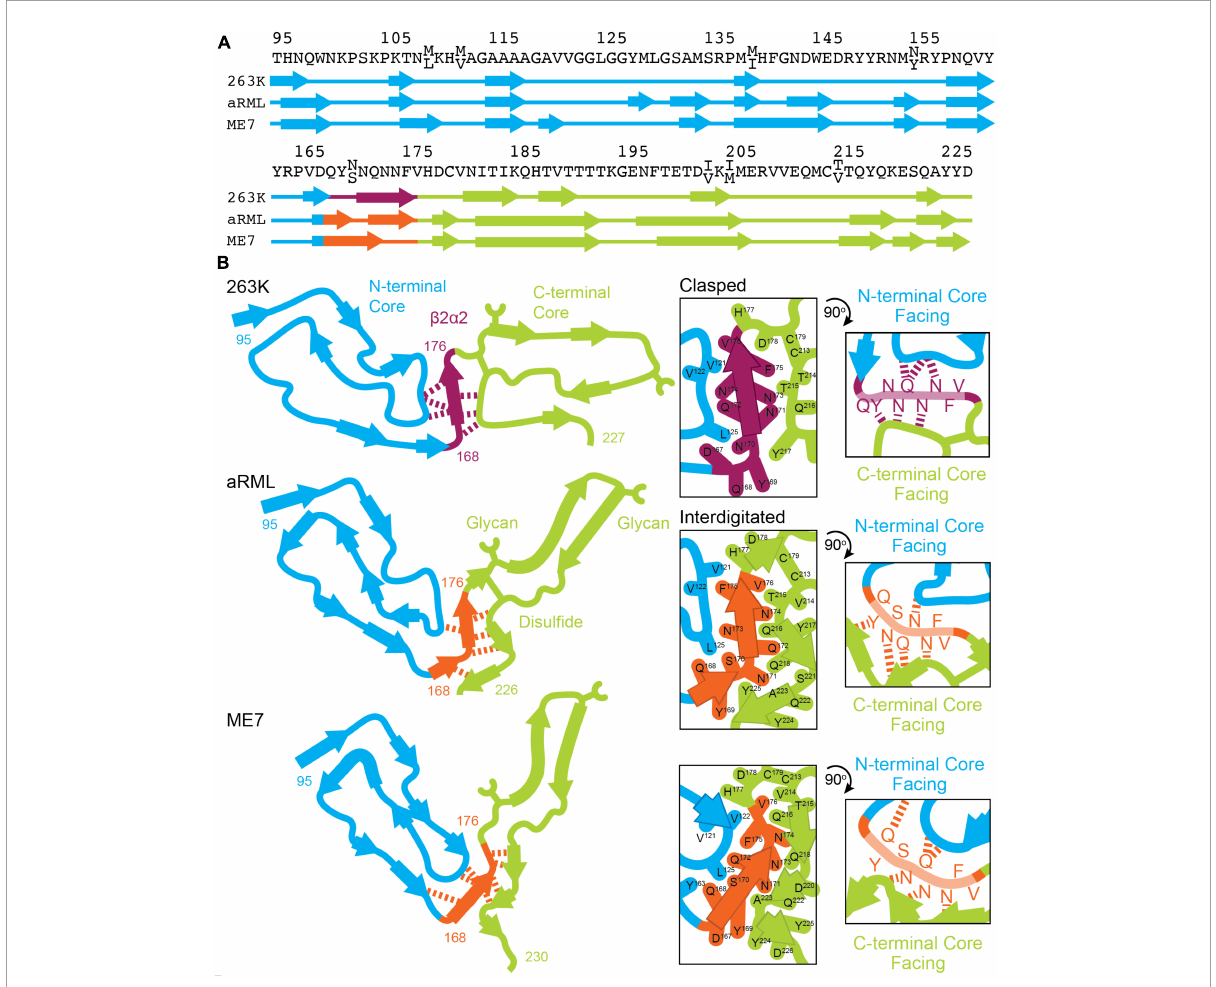
FIGURE9 Conformation of β 2 α 2 loop segment in PrP Sc fibril structures. (A) Sequence of residues associated with 263K, aRML, and ME7 prion fibrils with numbering according to hamster PrP. (B) Schematics of the recently reported structures of PrP Sc determined by single particle cryo electron microscopy (cryoEM) (Hoyt et al., 2021; Kraus et al., 2021; Manka et al., 2021, 2022). Residues of interest are numbered, and hydrogen bonds between the β 2 α 2 loop and N- and C-terminal cores are shown in as dashed lines.